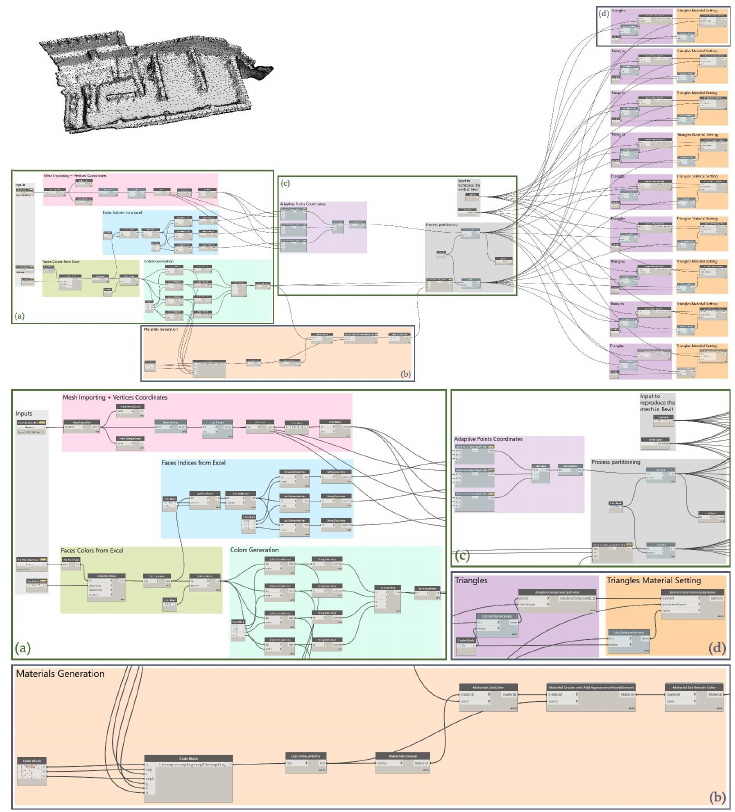
Figure 11. VPL script developed for Workflow B, in the Dynamo for Revit environment (e.g., “North_1.RVT”). After the generation of the triangular instances, the subsequent step was to assign the effective colours, as the newly realised Revit Materials, to the “Photogram metric Color” parameter. Lastly, the adaptive triangles to be created were partitioned into 2000-unit batches for the hardware to be able to process the script.